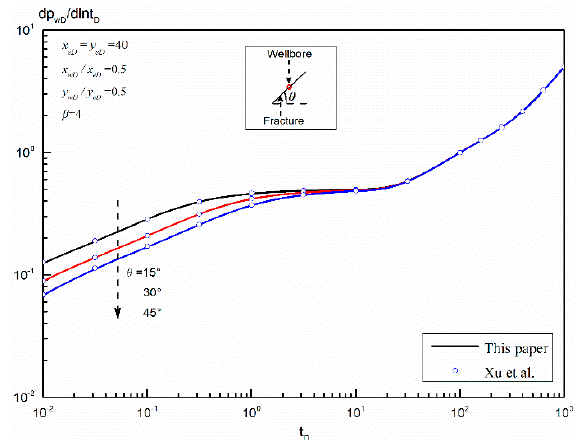
Figure 3. Validation of a fractured well located at different positions in an anisotropic rectangular reservoir. ( a ) central well; ( b ) eccentric well.